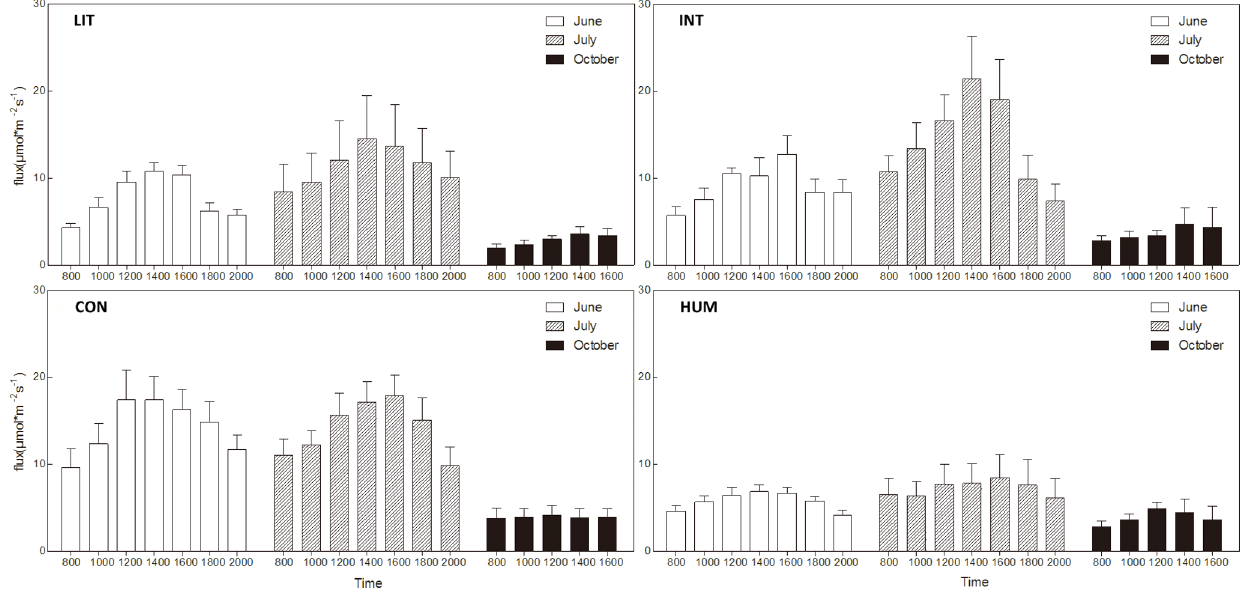
Fig. 4. Diurnal CO 2 flux from the four sites in 2012. The diurnal dynamics of CO 2 flux from the four sites were collected in June, July and October